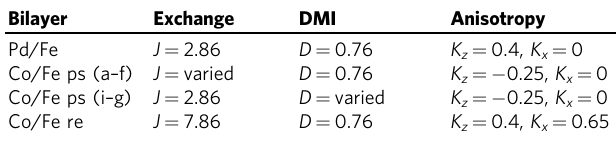
Fig. 5 Details of the skyrmion-edge interaction in hcp-stacked Pd/Fe. a – c Differential conductance (d I /d U ) maps of hcp-stacked Pd/Fe islands with localized edge-skyrmions (blue arrows) and more stripped-out spiral stripes (green arrows) at the island edge. Dashed lines indicate the direction of the dislocation lines in the adjacent Co/Fe. d , e Simpli fi ed sketches showing the two skyrmionic objects pinned at different Co/Fe edge types and their relation to the direction of the magnetocrystalline anisotropy K at the rim. All d I /d U maps: tunneling current I = 3 nA, bias voltage U = 710 mV, B = 2 T. COMMUNICATIONS PHYSICS| (2022) 5:19